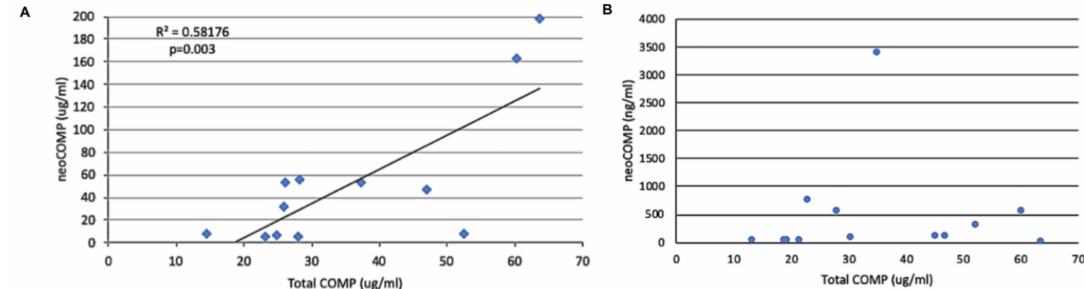
Figure 7. The relationship between the total COMP content of the tendon sheath synovial fluids (determined using a homologous inhibition assay) and concentration of the COMP neoepitope determined by the original assay ( A ) and the modified assay ( B ) containing the spanning peptide to block cross-reactivity of the neoepitope antiserum with intact COMP. Note the significant relationship for the original assay, reflecting the cross-reactivity of the neoepitope antiserum but the lack of relationship with the cross-reactivity